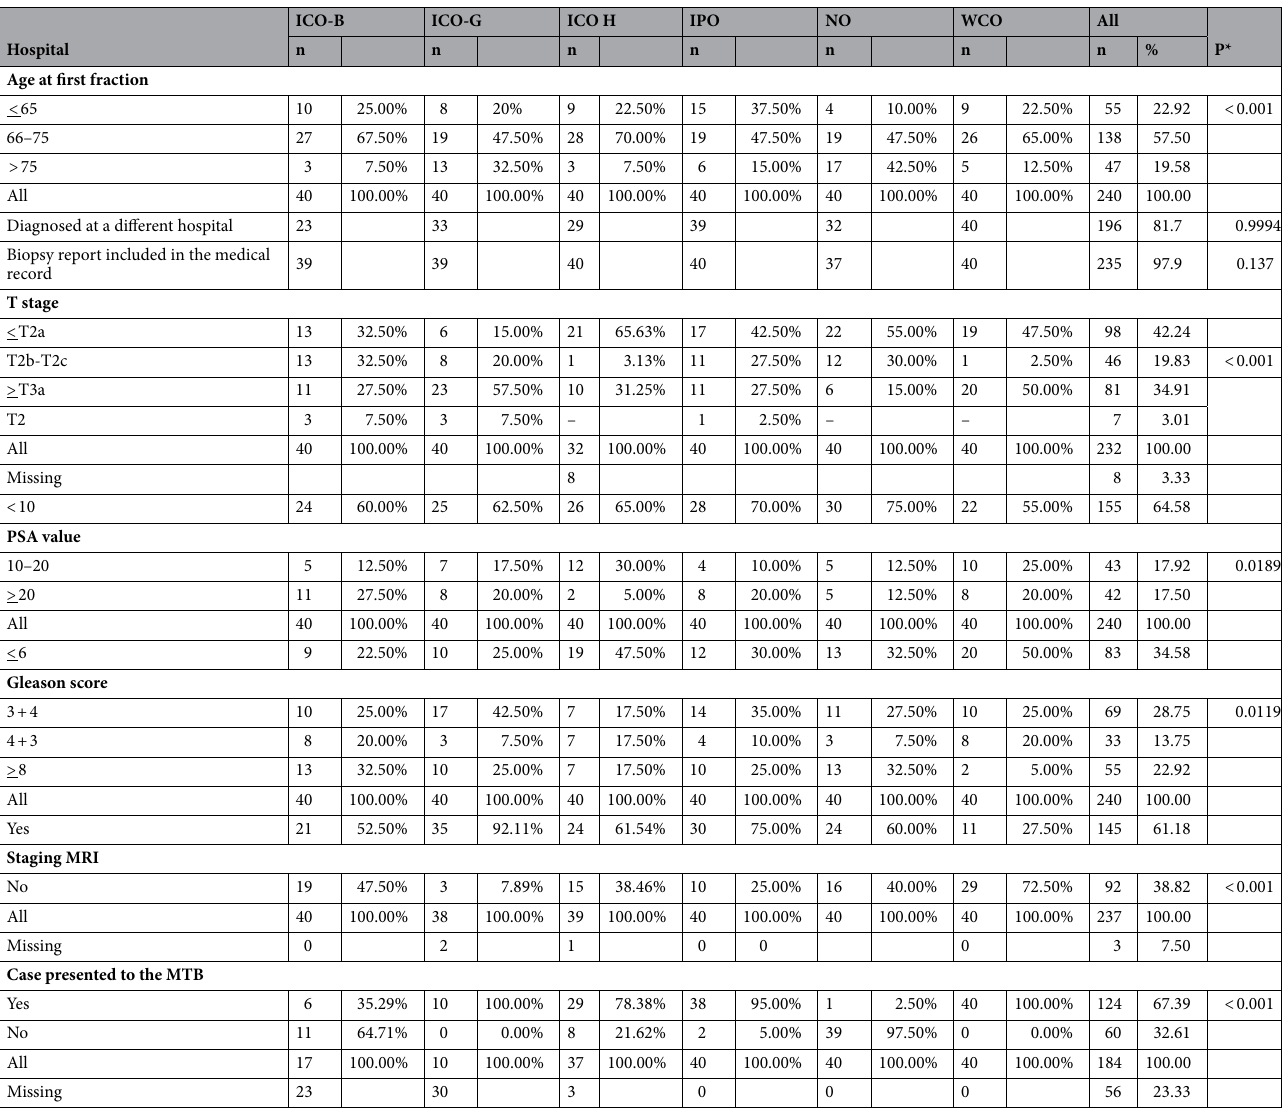
Table 1. Characteristics of the sample (n = 240) by institution. MTB multidisciplinary tumor board, PSA prostate specific antigen, WCO Wielkopolskie Centrum Onkologii, IPO Instituto Português de